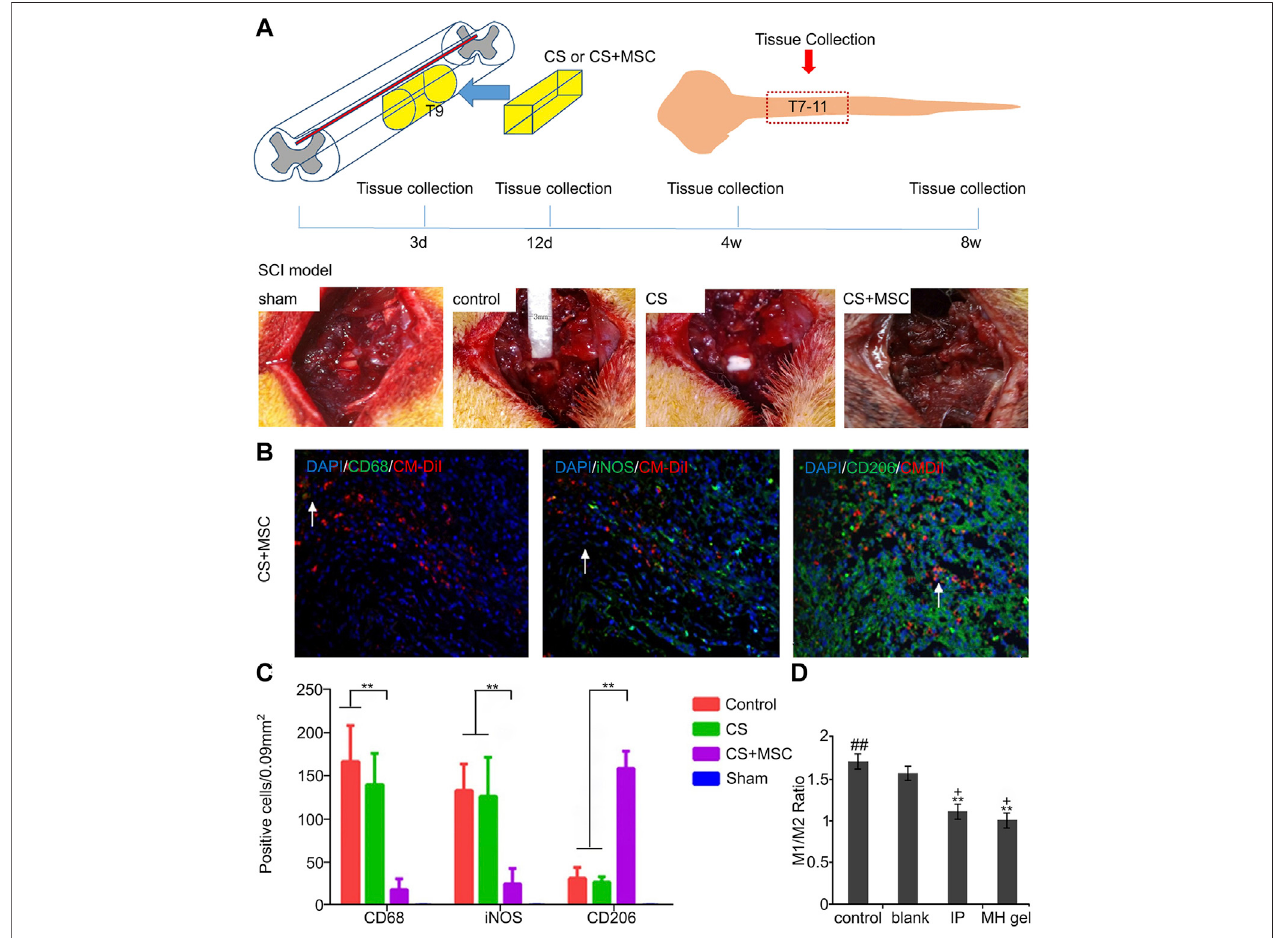
FIGURE 2 | Regulation of macrophages/microglia by biomaterials loaded with different substances. (A) SCI model construction, 3 mm segment of left spinal cord ofratT9wasremoved,andCSorCScompositeMSCswereimplanted. (B) CD68,iNOSandCD206immunohistochemicalstainingofspinalcordslicesinthetreatment group. (C) The bar graph shows the number of CD68, iNOS and CD206 positive cells at 3, 12, and 28 days after surgery. (D) M1/M2 ratio of untreated control group, blank gel group, local MH gel group and whole body IP treatment group. Reproduced with permission from (65,